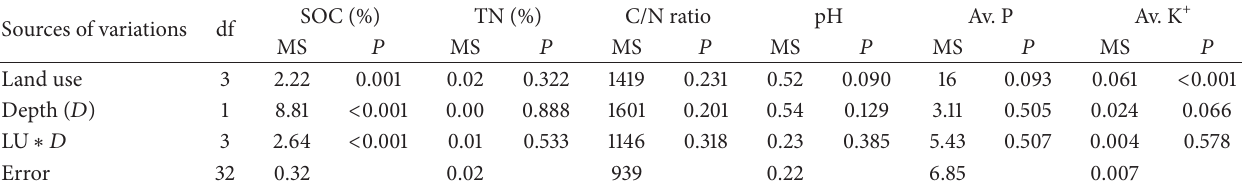
O), Av. P, and Av. K in relation to land use and soil depths. 2